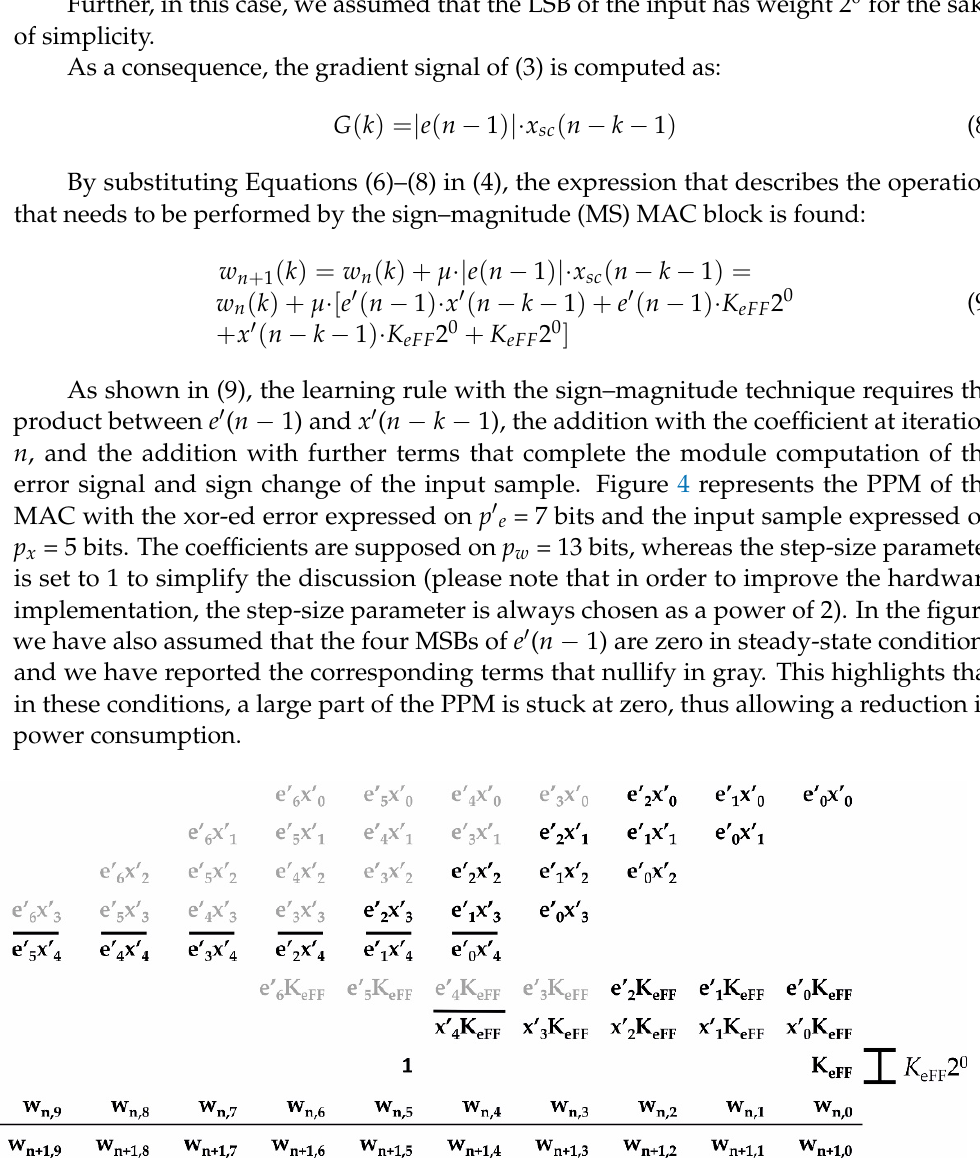
Figure 4. Partial product matrix of the sign–magnitude MAC block. The gray partial products are zero thanks to the sign–magnitude technique.